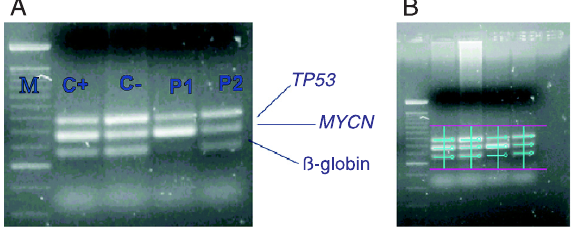
Figure 1. Gel electrophoresis showing the amplification products of the MYCN oncogene by differential PCR. A , Lanes: M = mo- lecular size markers; C+ = positive control of NB19 cell lines; C - = negative control from TPH-1 cell lines; P1 = neuroblastoma patient with amplified MYCN gene; P2 = neuroblastoma patient with unamplified MYCN gene. B , Densitometric scanning of the